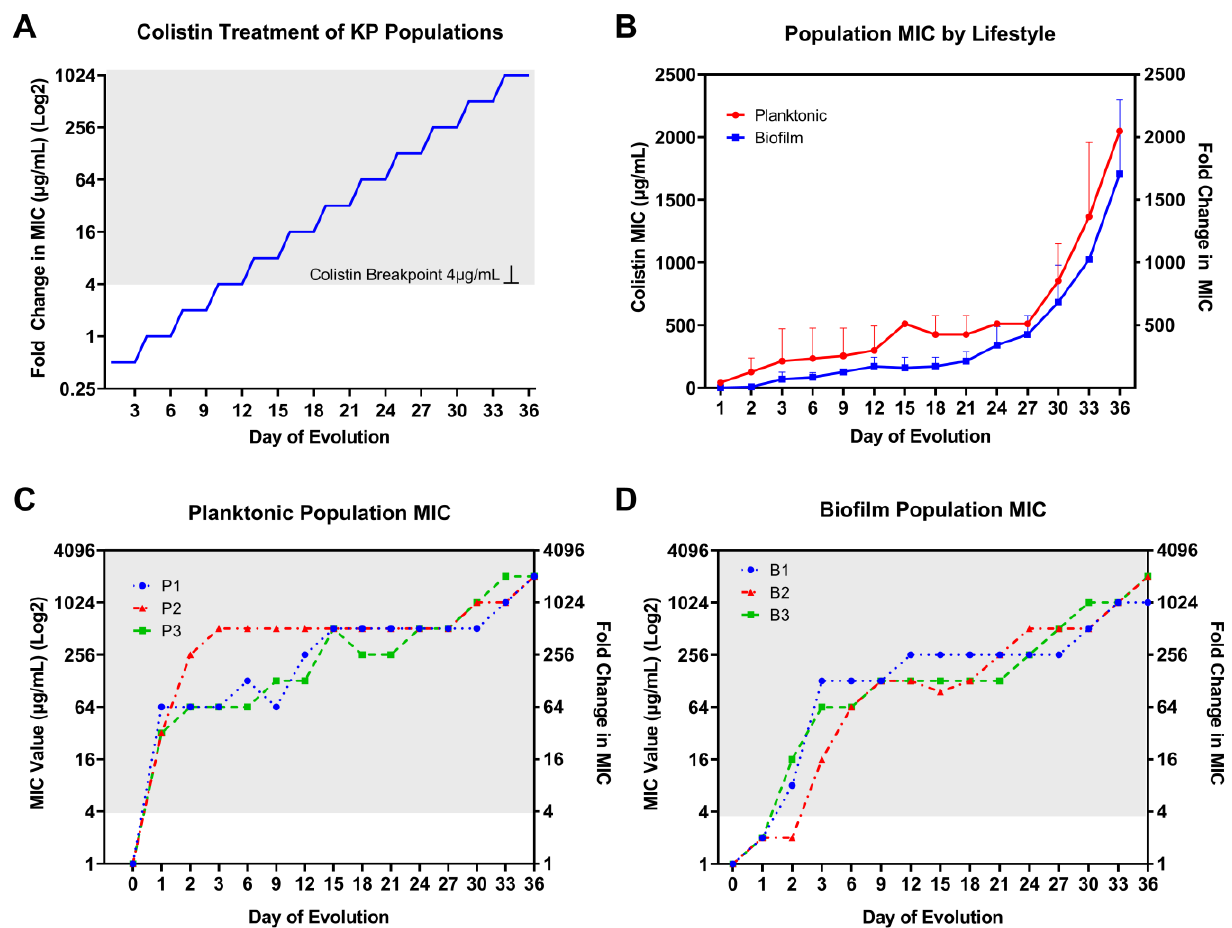
Figure 2. Colistin selection and population MIC result by bacterial lifestyle. ( A ) Colistin treatment for KP planktonic and biofilm populations started at ½ MIC; the selection concentrations were doubled every three days for 36 days. ( B ) Colistin population MIC results averaged among three replicate colistin-treated KP populations by bacteria lifestyle. Rapid resistance to colistin was observed for ( C ) planktonic and ( D ) biofilm individually evolved populations after 36 days of colistin selection pressure. By day 36, there was a 1024–2048-fold increase in colistin MIC compared to baseline level. The resistance is distinguished in gray background when MIC is above the CLSI-determined clinical breakpoint at 4 µg/mL for colistin.